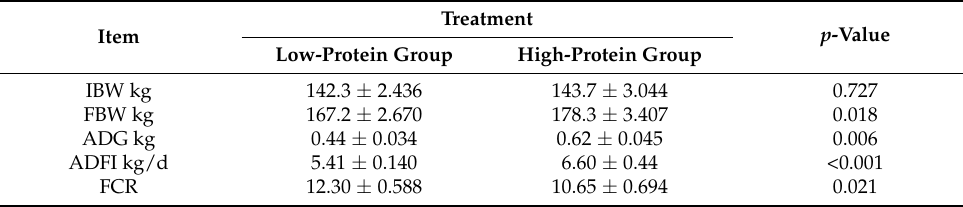
Table 2. Effects of the dietary protein level on the growth performance of growing yaks.